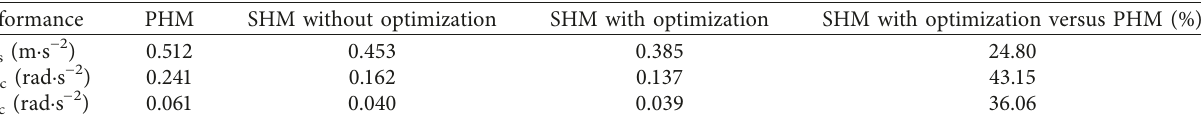
Table 4: The weighted RMS values under a high excitation frequency, 35Hz, of the